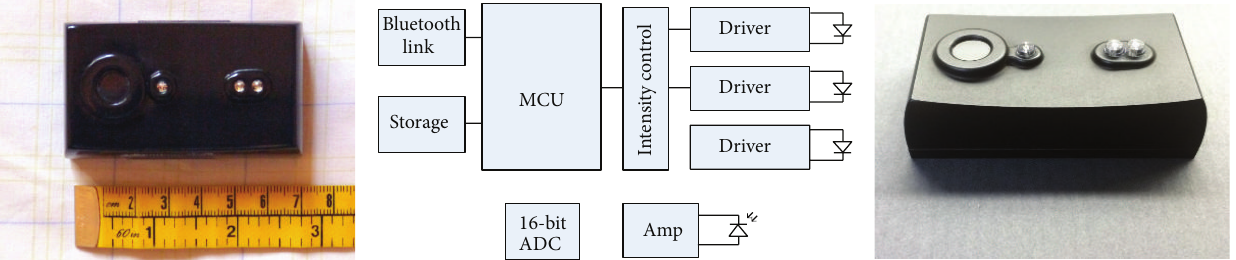
Figure 1: CW SR NIRS device. First prototype; block diagram and device as field tested.